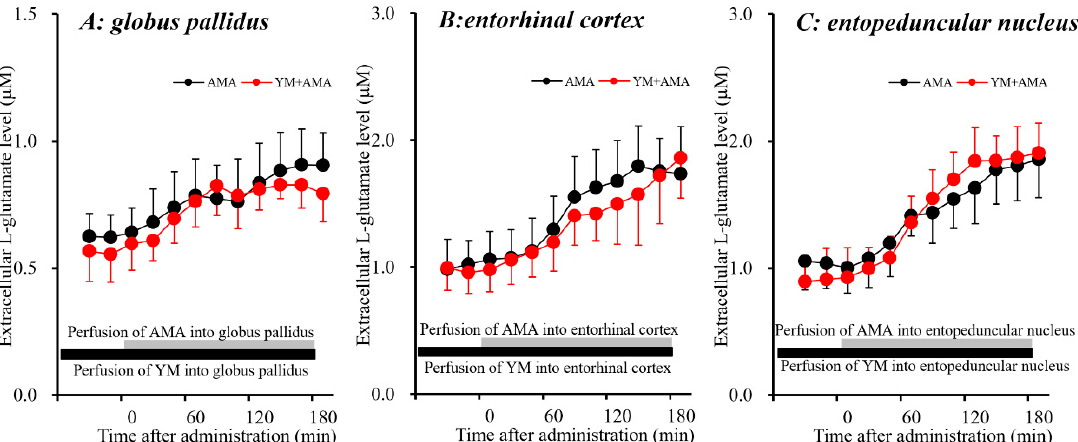
Figure 4. Interaction between perfusion with AMA (50 µ M) and YM298198 (50 µ M) into the globus pallidus, entorhinal cortex and entopeduncular nucleus and respective extracellular L-glutamate levels in the respective globus pallidus ( A ), entorhinal cortex ( B ) and entopeduncular nucleus ( C ). ( A – C ) indicate the e ff ects of perfusion of AMA with or without YM298198 into the globus pallidus, entorhinal cortex and entopeduncular nucleus on extracellular L-glutamate levels. The initial perfusion medium was MRS with or without YM298198 (50 µ M) (black bars). After the stabilization of L-glutamate levels in the perfusate, the perfusion medium was switched to the same MRS containing AMA (50 µ M) (gray bars). Ordinates: mean ± SD ( n = 6) of the extracellular L-glutamate level ( µ M); abscissa: time after administration of AMA (min). The significant e ff ects of YM298198 on AMA-induced L-glutamate release was not detected by LME with Tukey’s post hoc test.